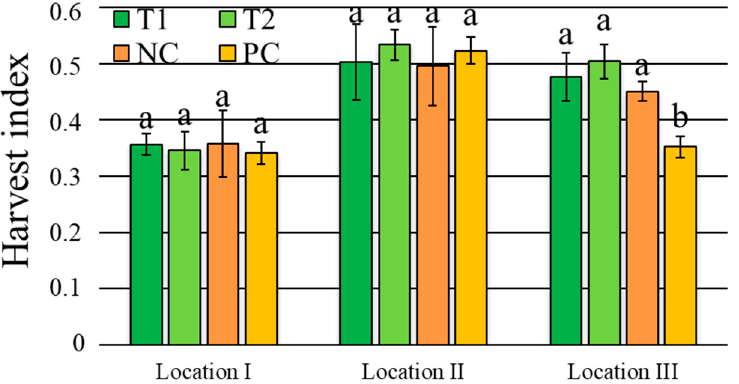
Figure 6. Location × treatment interaction derived from two-way analysis of variance (ANOVA) on the durum wheat harvest index. Bars represent the standard deviations ( n = 4). Di ff erent le tt ers in- dicate statistical signi fi cance at p ≤ 0.05 (Fisher’s LSD test). T1: DiS-NH 2 at a standard dosage (0.75 g m − 2 ); T2: DiS-NH 2 at a double dosage (1.5 g m − 2 ); NC: negative control (no weeding); PC: positive control (chemical weeding).